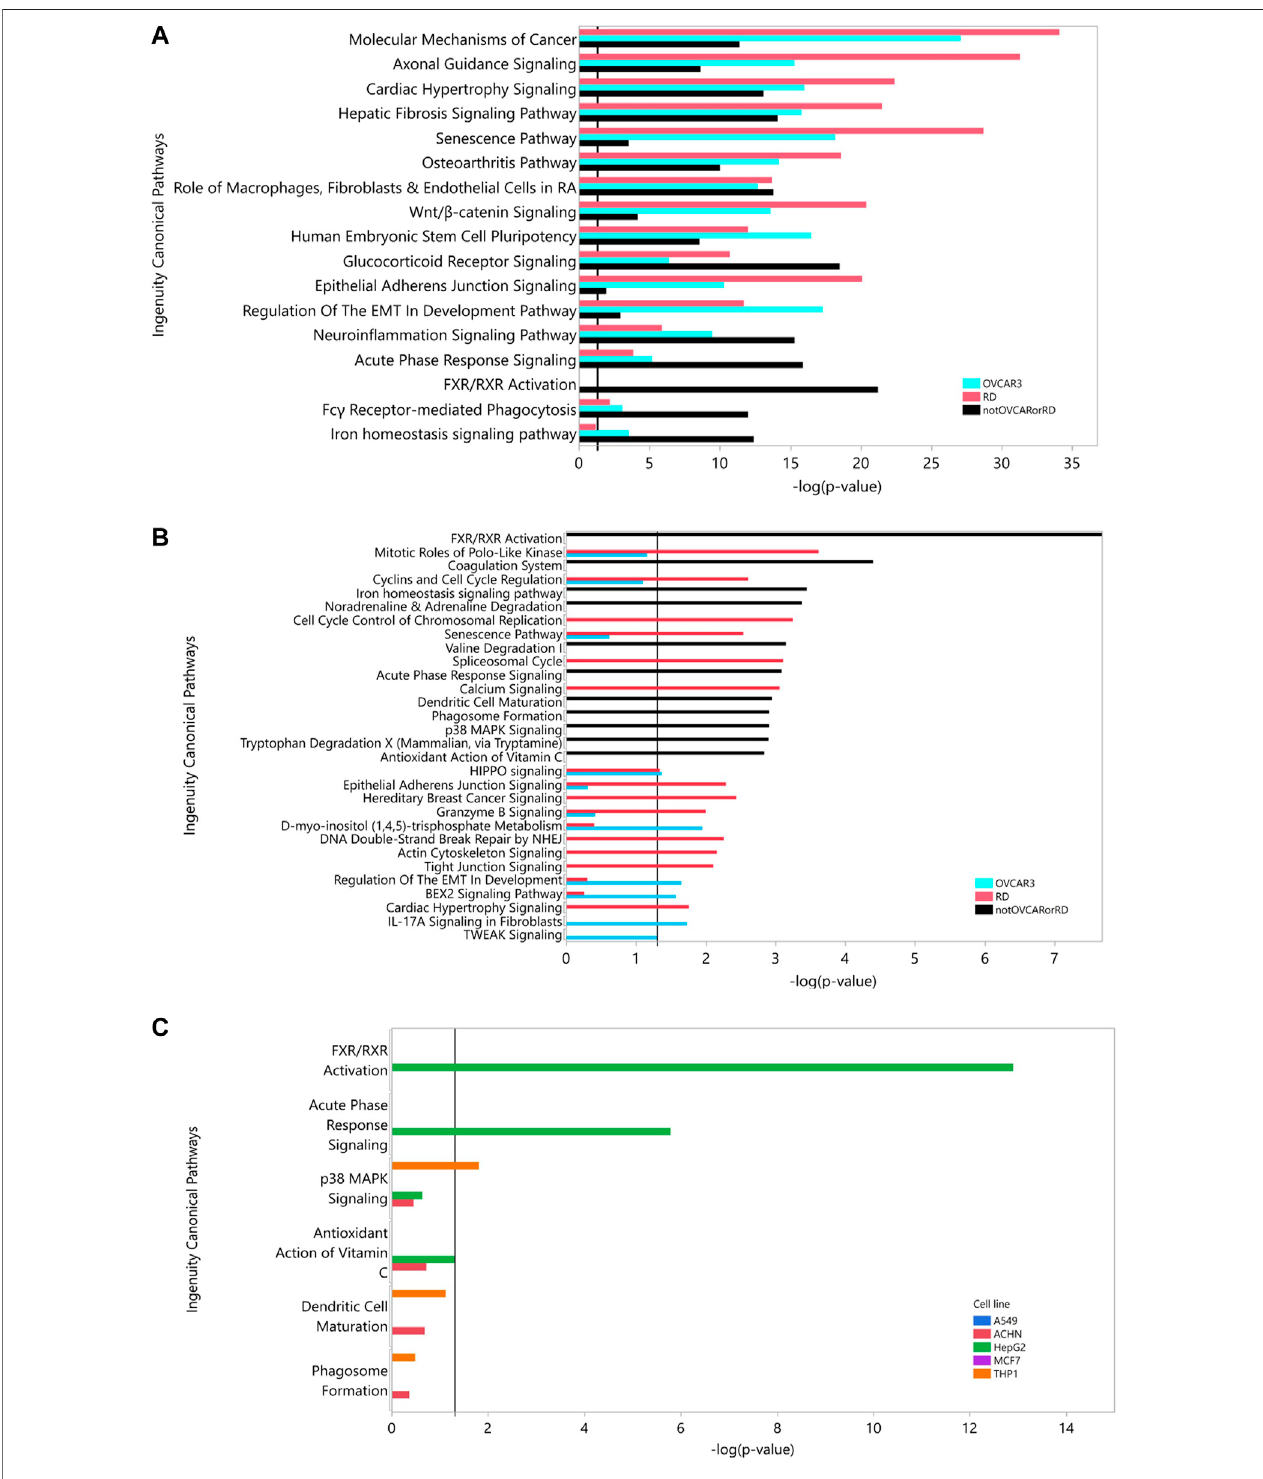
FIGURE 5 | Pathway Analysis: Using the DARTable Genome to identify the relevant cell lines. (A,B) : Pathways signi fi cantly overrepresented for DARTable genes expressed above average in the top 2 cell lines (RD and OVCAR-3). DARTable genes expressed in RD (red) and OVCAR-3 (blue) and DARTable genes that were not in expressed in either cell lines were used as inputs (black). Pathways signi fi cantly enriched [ p < 0.05 or – log( p ) > 1.3], indicated by vertical black line, were identi fi ed after comparison to either the human genome (A) or the DARTable genome (B) . (C) Enrichment analysis of the 5 pathways that were not represented in the top 2 cell lines (RD and OVCAR-3). Enrichment analysis was performed using data from the other cell lines: A549, ACHN, HepG2, MCF7 and THP-1 pathways signi fi cantly enriched [ p < 0.05 or – log( p ) > 1.3], indicated by vertical black line, were identi fi ed after comparison to the DARTable genome.